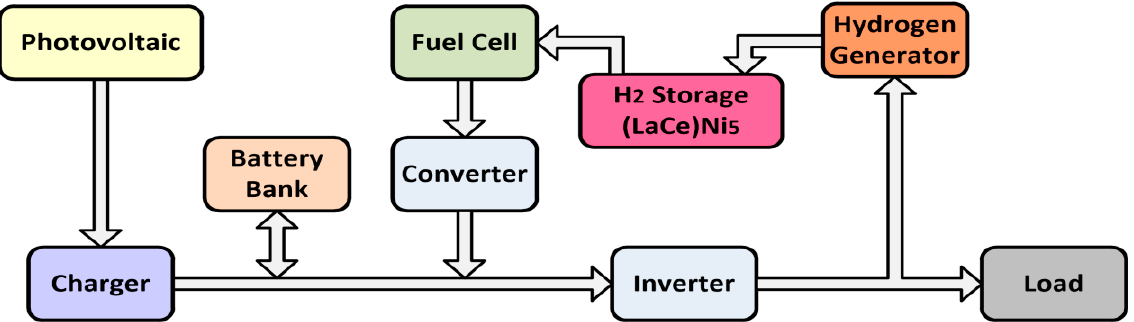
Figure 3. The basic scheme of the experimental hybrid energy system (HHS) energetic system.